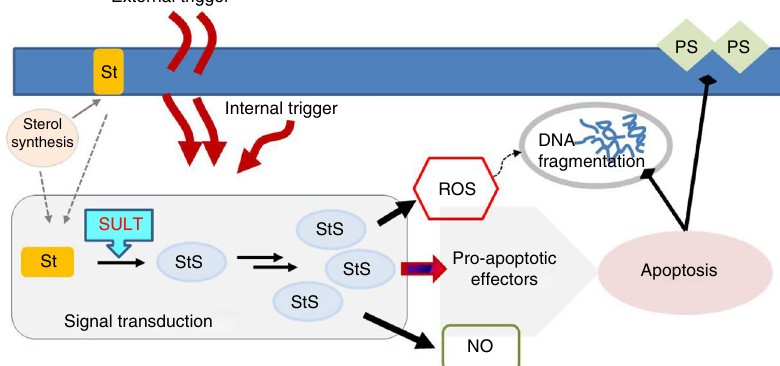
Fig. 6 Signaling transduction by sterol sulfates in S. marinoi . The accumulation of sterol sulfates (StS) has a central role in regulating the diatom cell fate and the associated biochemical responses. Increase of their intracellular levels above a threshold of 0.5 – 0.6 pg per cell alters redox balance and induces rapid generation of NO. The ultimate effect is the launch of apoptotic events that lead to cell death. The effectors of this last process have not been identi fi ed yet but metacaspases are reported in S. marinoi and other diatoms. Synthesis of StS requires sulfonation of the sterol substrates, thus control of the pathway may concern de novo synthesis of sterols, mobilization of sterols from the membrane bilayer or up-regulation of SULT expression. Each of these